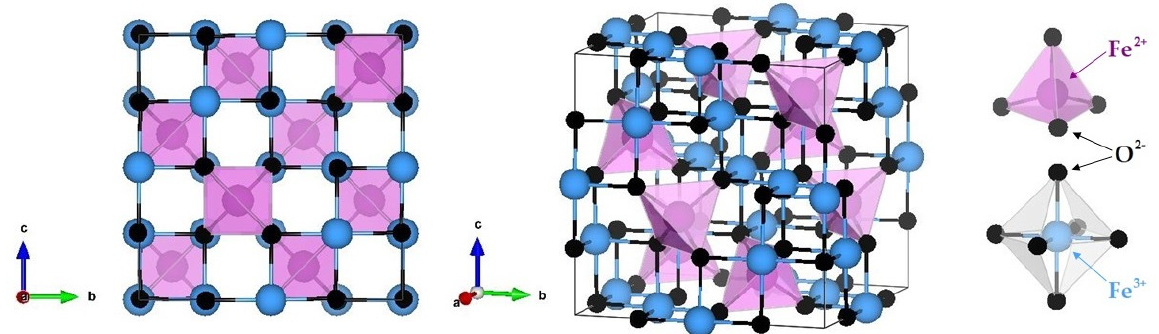
Figure 2. Spinel ferrite structure (inverse) for Fe 3 O 4 , presented along the a direction and as a 3D projection (not marked octahedra for clarity). Reprinted with permission from [63] . Copyright (2021) Creative Commons Attribution.